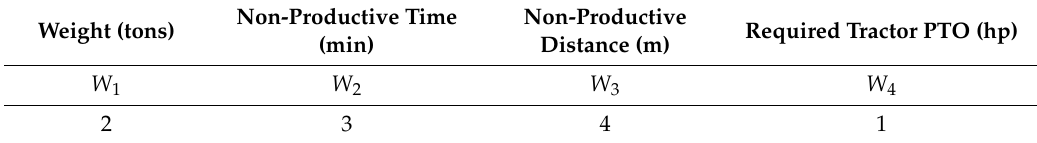
Table 10. The weight matrix (non-productive distance: the highest